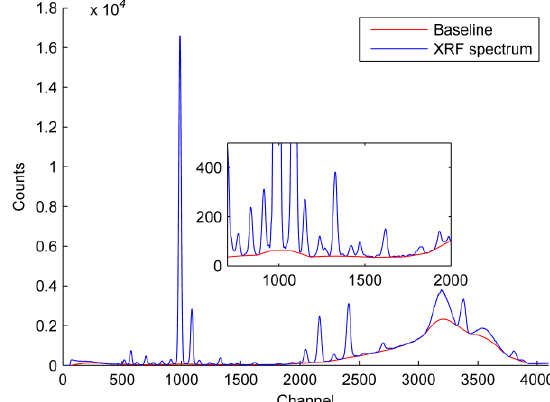
Figure 5 Baseline correction after denoising with DWT. Inset shows a spectrum enlarged for 800–2000 channels.